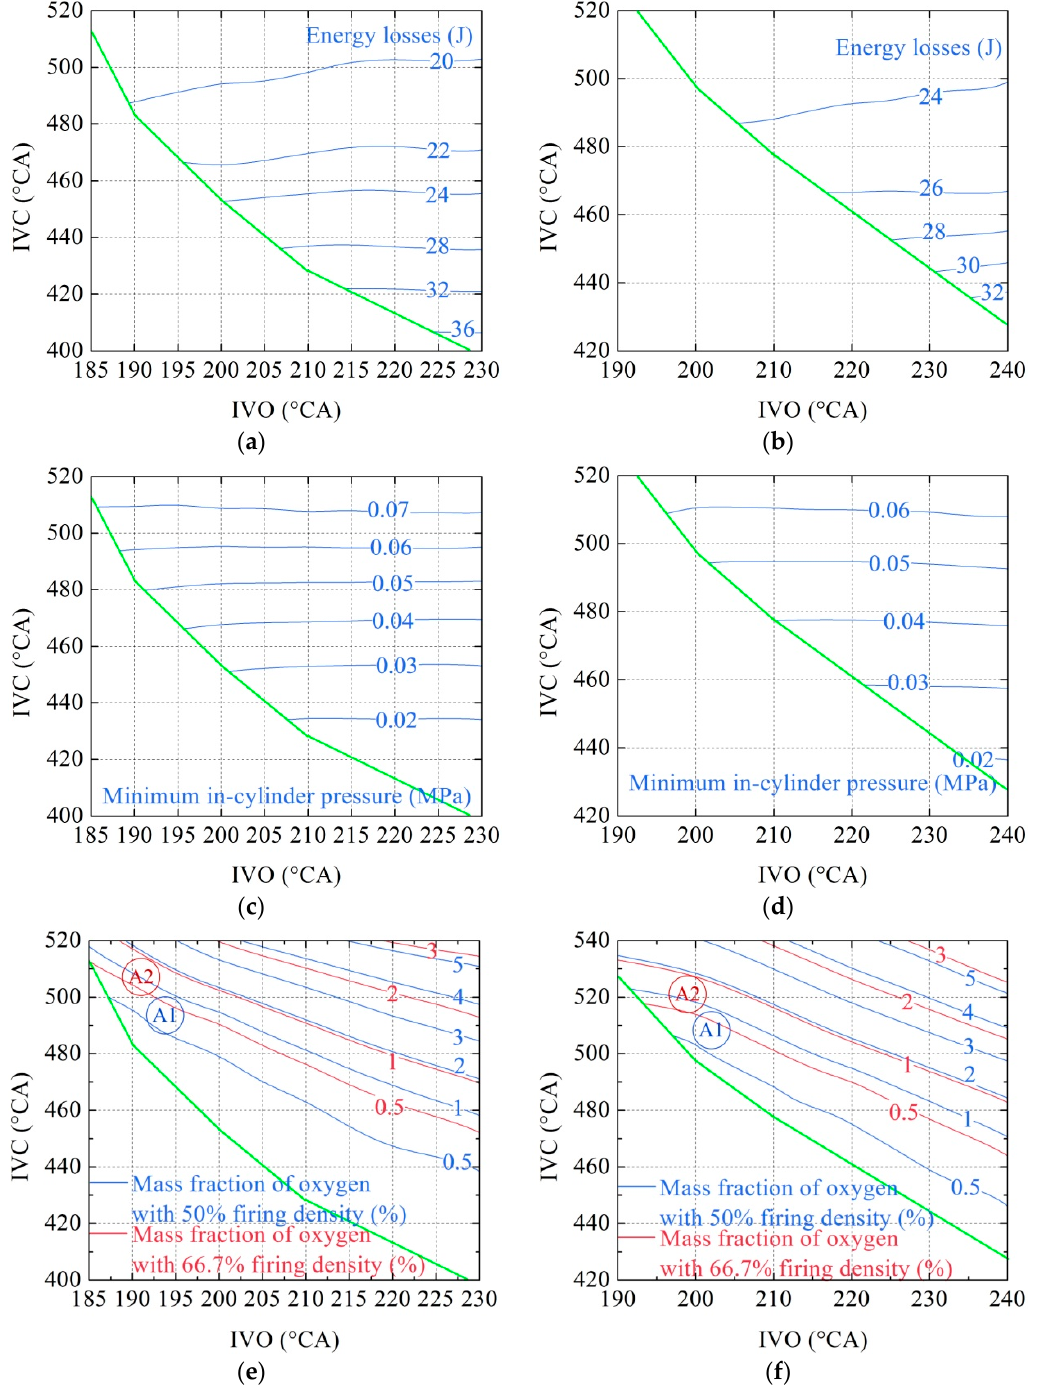
Figure 19. The results of 2400 rpm and 3200 rpm with the proposed VCD valve strategy: ( a ) Total energy losses at 2400 rpm; ( b ) Total energy losses at 3200 rpm; ( c ) The minimum in-cylinder pressure of the inactive cycle at 2400 rpm; ( d ) The minimum in-cylinder pressure of the inactive cycle at 3200 rpm; ( e ) Mass fraction of oxygen at 2400 rpm; ( f ) Mass fraction of oxygen at 3600 rpm.